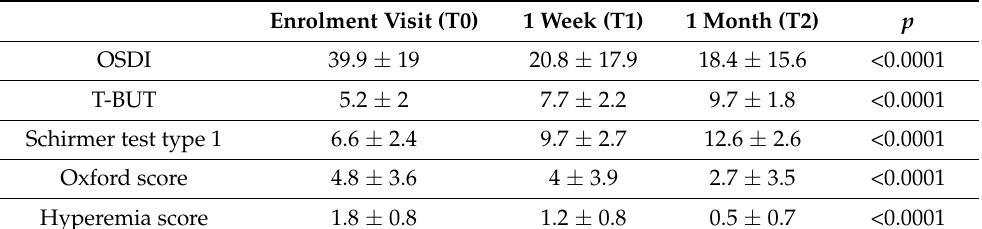
Table 1. Average values of the clinical evaluation of dry eye in the study group at different time points.